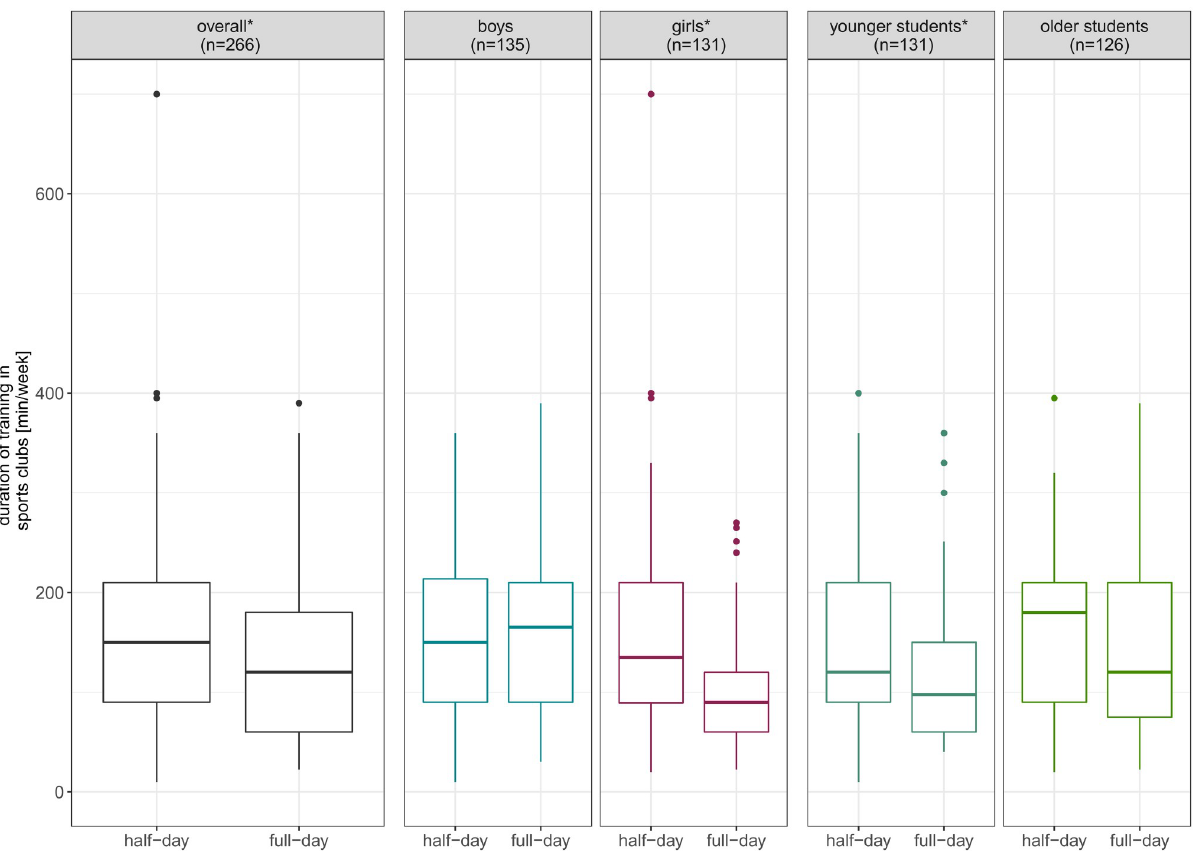
Fig 3. Duration of training in sports clubs per week (Mdn) overall and stratified for gender and age group (N = 266). The boxplots display the median and the 2 nd and 3 rd quartile. � indicates a statistically significant difference on the alpha-level α �